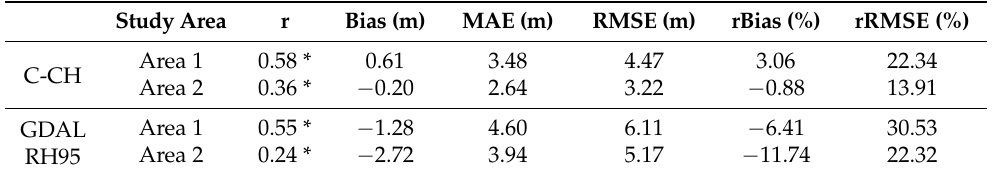
Table 3. Accuracies of the FPSF-CH for canopy height mapping (C-CH) and GDAL RH95 compared to high-quality GEDI validation data (GEDI RH95). The negative bias represents an underestimation compared to GEDI RH95. The asterisk represents a significant correlation ( p < 0.05). Study